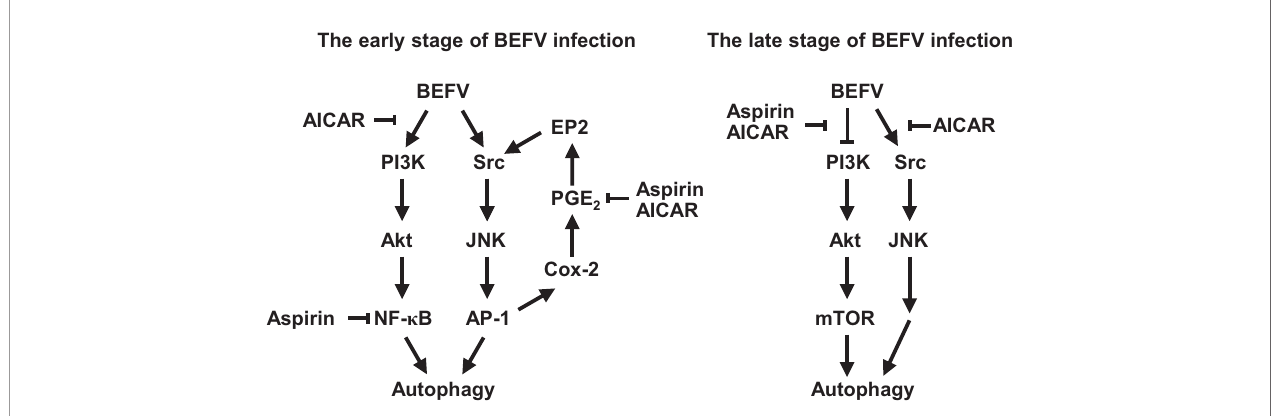
FIGURE 8 | Models illustrating the mechanisms of AICAR and aspirin-mediated inhibition of BEFV-induced autophagy. At the early stage of BEFV infection, AICAR suppresses the BEFV-activated PI3K/Akt/NF- k B and Src/JNK/AP-1/Cox-2/PGE2/EP2 pathways, and aspirin suppresses NF- k B and the BEFV-activated Src/JNK/ AP-1/Cox-2/PGE2/EP2 pathway. At the late stage of BEFV infection, AICAR reverses the BEFV-inactivated PI3K/Akt/mTOR pathway and the BEFV-activated Src/ JNK/Bcl-2 pathway while aspirin reverses the BEFV-inactivated PI3K/Akt/mTOR